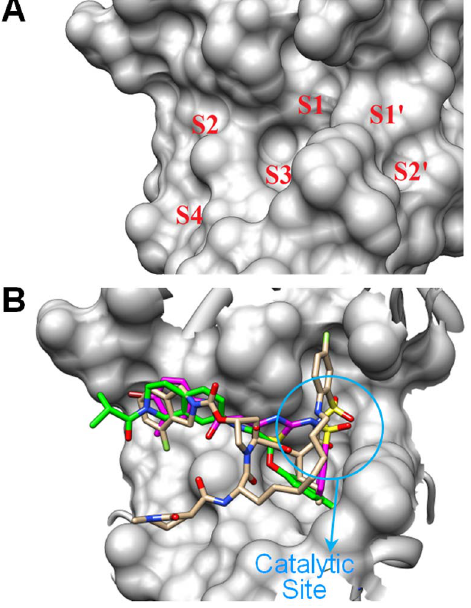
Figure 6. Substrate binding sites and docking studies. ( A ) The surface of the NS3 protease substrate binding sub-sites. The S4-S2’ binding pockets are labeled in red. ( B ) Active-site view of docked 12 (colored in green) and 13 (colored in magenta) overlaid with a known macrocyclic inhibitor ITMN191 (colored in tan) from crystal structure (PDB code: 4A92). Figure prepared with Chimera v1.6.1, UCSF, 2012 [37].